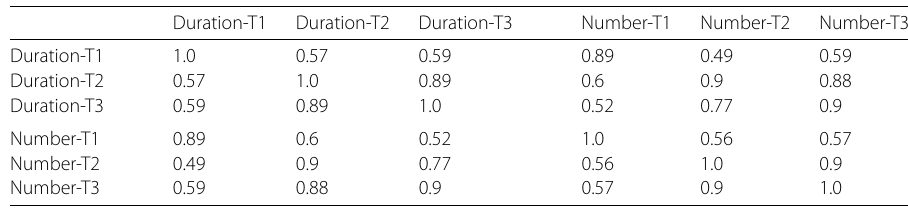
Table 3 Pearson correlation coefficients between term-aggregated networks (a) Communication vs. communication ( p = 0 for all